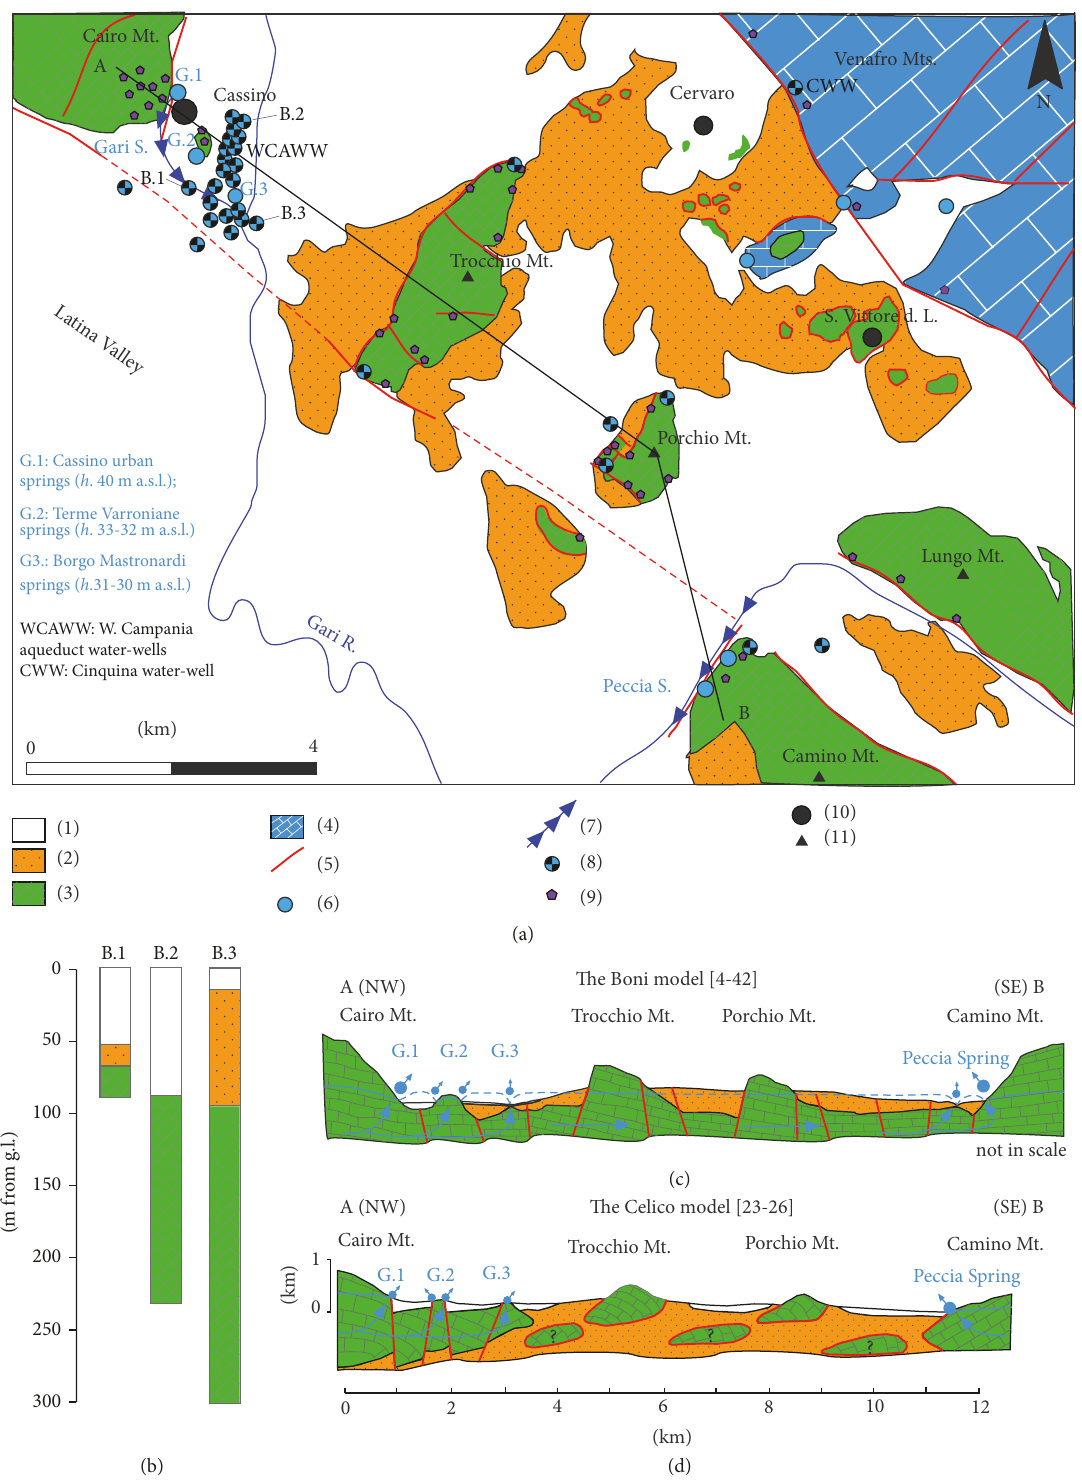
Figure 2: (a) Geological and hydrogeological map of the Cassino plain, from Gari to Peccia Springs. Key to the legend: (1) Quaternary unit (QU) made of clastic aquifers and aquitards; (2) terrigenous unit (TU) made of clastic aquiclude and aquitards from Miocene foredeep clayey deposits; (3) limestone aquifer unit (CU) made of continuous layers of Mesozoic to Cenozoic limestones; (4) dolostone unit (DU) made of Lower Mesozoic massive dolostones; (5) main tectonic lineament; (6) karst punctual spring; (7) karst streambeds; (8) water-well exploiting the carbonate aquifer; (9) locations of the geomechanical analysis; (10) town; (11) mountain peak; (b) examples of boreholes stratigraphies from CASMEZ [26]. No karst caves have been reported in the original documents; (c) redrawn hydrogeological model from Boni and Bono [42]. The authors [4, 42] schematize the carbonate bedrock via a horst and graben setting and a flux from Gari Springs (G1, G2, and G3) to Peccia Springs. (d) modified hydrogeological section from Celico [23]. Celico [23–25] supposed the interruption of the carbonate bedrock and no underground connection between Gari Spring and Peccia